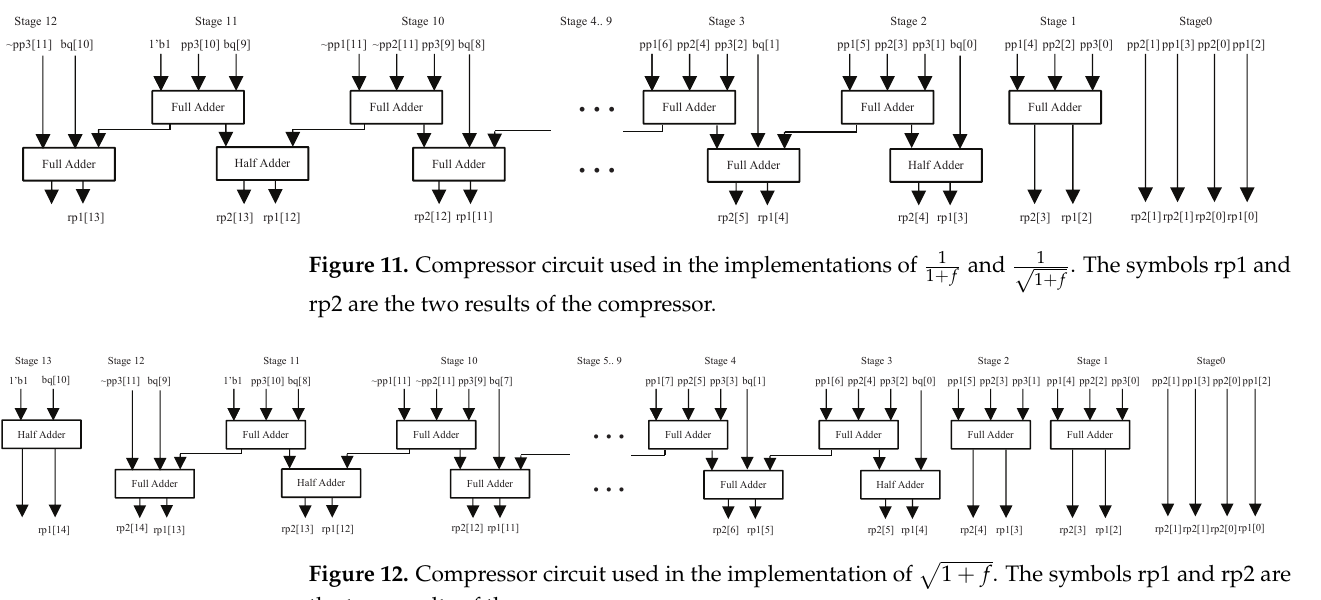
(cid:112) 1 + f . The symbols rp1 and rp2 are